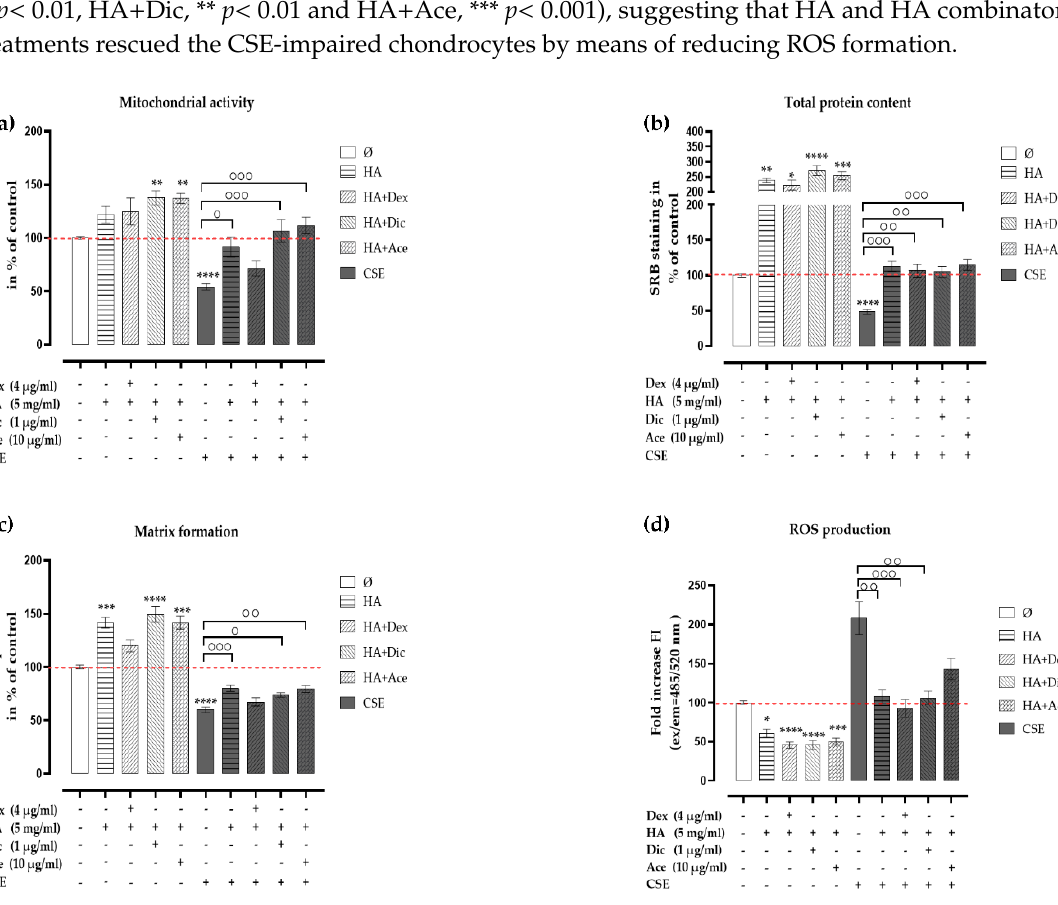
Figure 7. Analgesic / anti-inflammatory agents in combination with HA rescued CSE-impaired primary human chondrocytes. Cells ( N ≥ 3, n = 3) were incubated with Dex (4 µ g / mL), Dic (1 µ g / mL), or Ace (10 µ g / mL) in combination with HA (5 mg / mL) with or without 10% CSE. After 7 days of treatment, the viability of the cells was measured by ( a ) mitochondrial activity (resazurin conversion) and ( b ) total protein content (SRB staining). ( c ). Matrix formation of the cells was quantified by resolving the Alcian blue staining. ( d ). DCFH-DA assay was used to evaluate ROS production in primary human chondrocytes co-incubated with or without 10% CSE and treatments, and 0.01% v / v H 2 O 2 served as a positive control. Results are given as fold change of control (untreated cells, represented in red dotted line) and presented as mean ± SEM. * p < 0.05, ** p < 0.01, *** p < 0.001, **** p < 0.0001 compared to untreated cells, ◦ p < 0.05, ◦◦ p < 0.01, ◦◦◦ p < 0.001 compared to CSE treated cells.